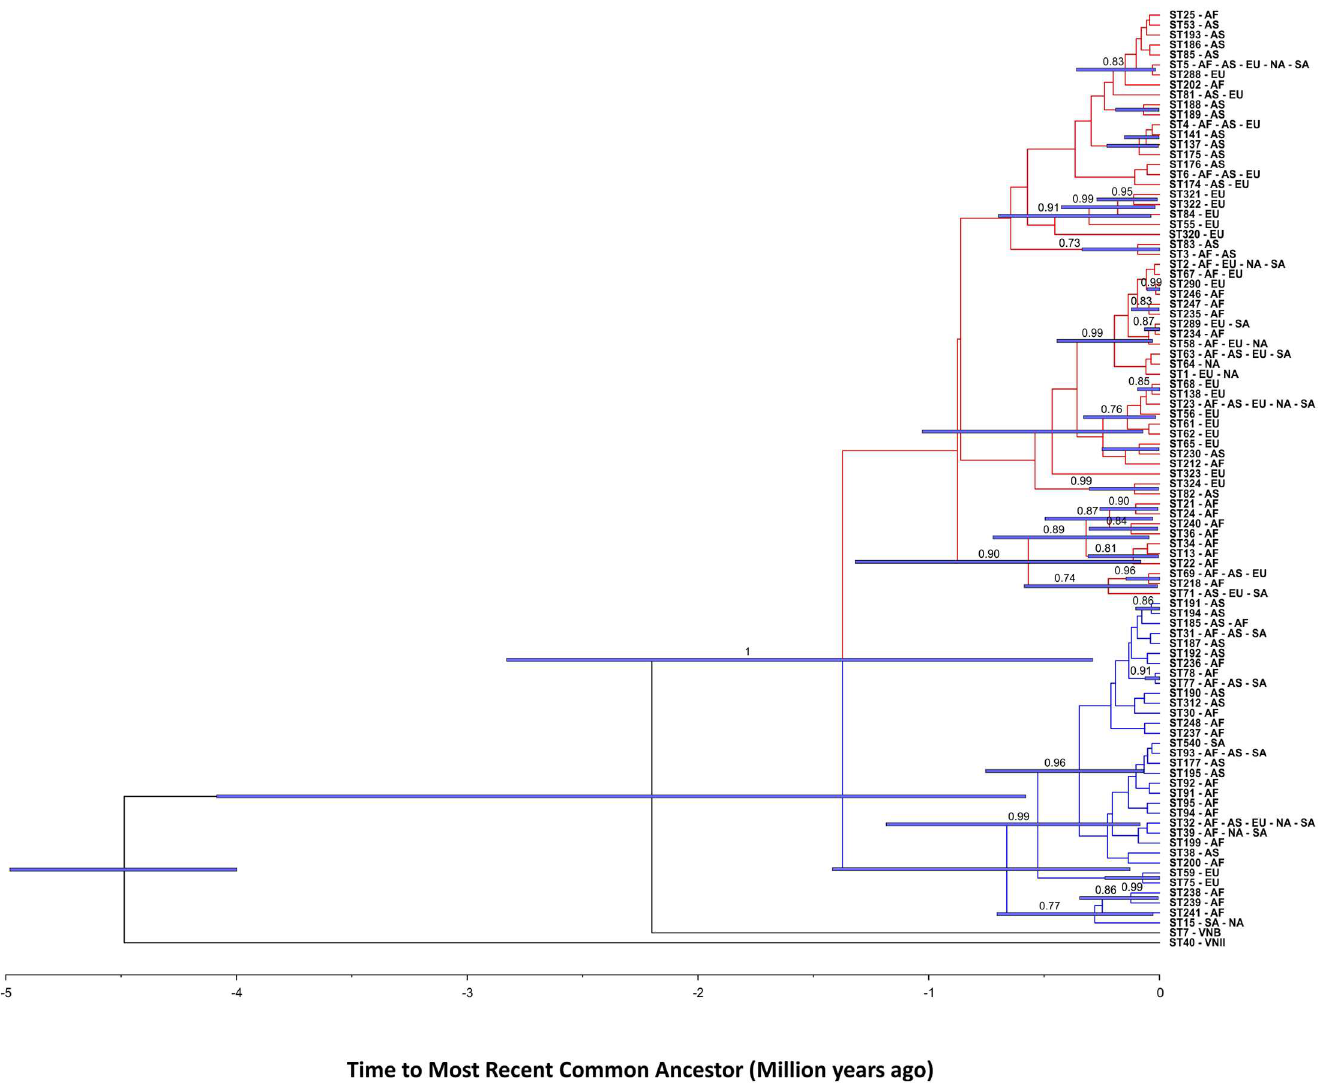
Fig 6. Coalescence gene genealogy of the Cryptococcus neoformans var. grubii VNI isolates evidencing the presenceof two main clusters that separated 0.29 to 2.8 million yearsago. Blue bars represent the 95% high posterior probabilityof the ages in the branches with a posterior probability limit of 0.5. The Bayesian posterior support values higherthan 70% are describedin the branches of the tree. One ST representingthe VNB (ST7) and one representing the VNII (ST40) lineagewere includedin the analysisas out-groups.The continentsof origin of the isolates are abbreviated as follows: AS: Asia, AF: Africa, EU: Europe, SA: South America, NA: North